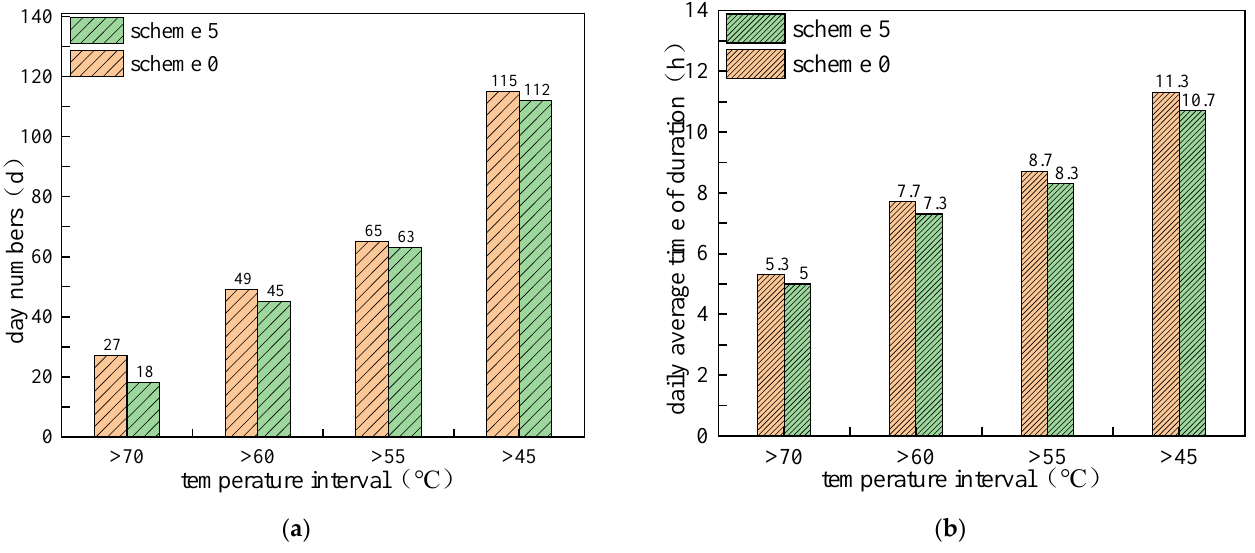
Figure 8. Duration times of daily maximum pavement temperature in different temperature ranges: ( a ) number of days; ( b ) Daily average duration in hours.